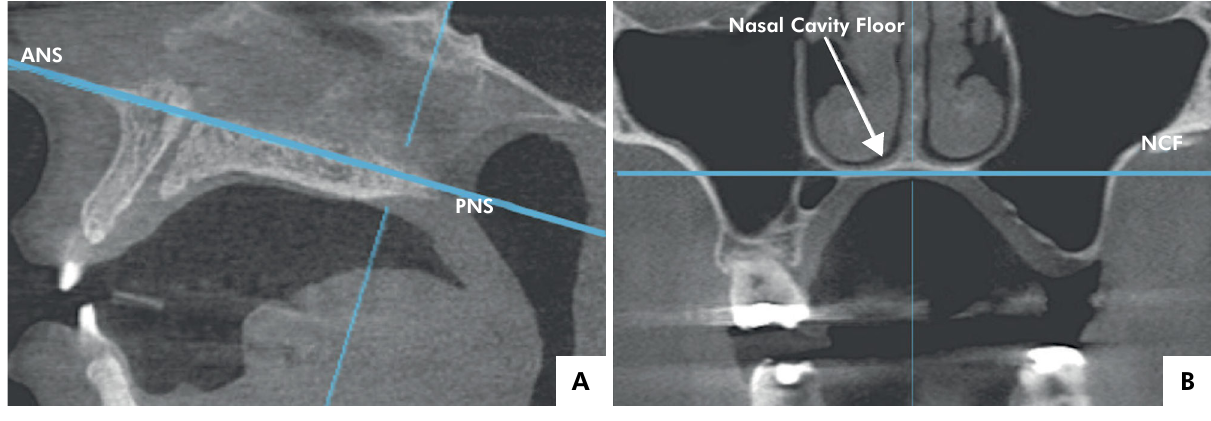
Figure 2. Sagital view of the parallel line to the horizontal plane, from the anterior nasal spine (ANS) to the posterior nasal spine (PNS) (2a). Coronal view of the nasal cavity floor (NCF) positioned parallel to the horizontal plane (2b).